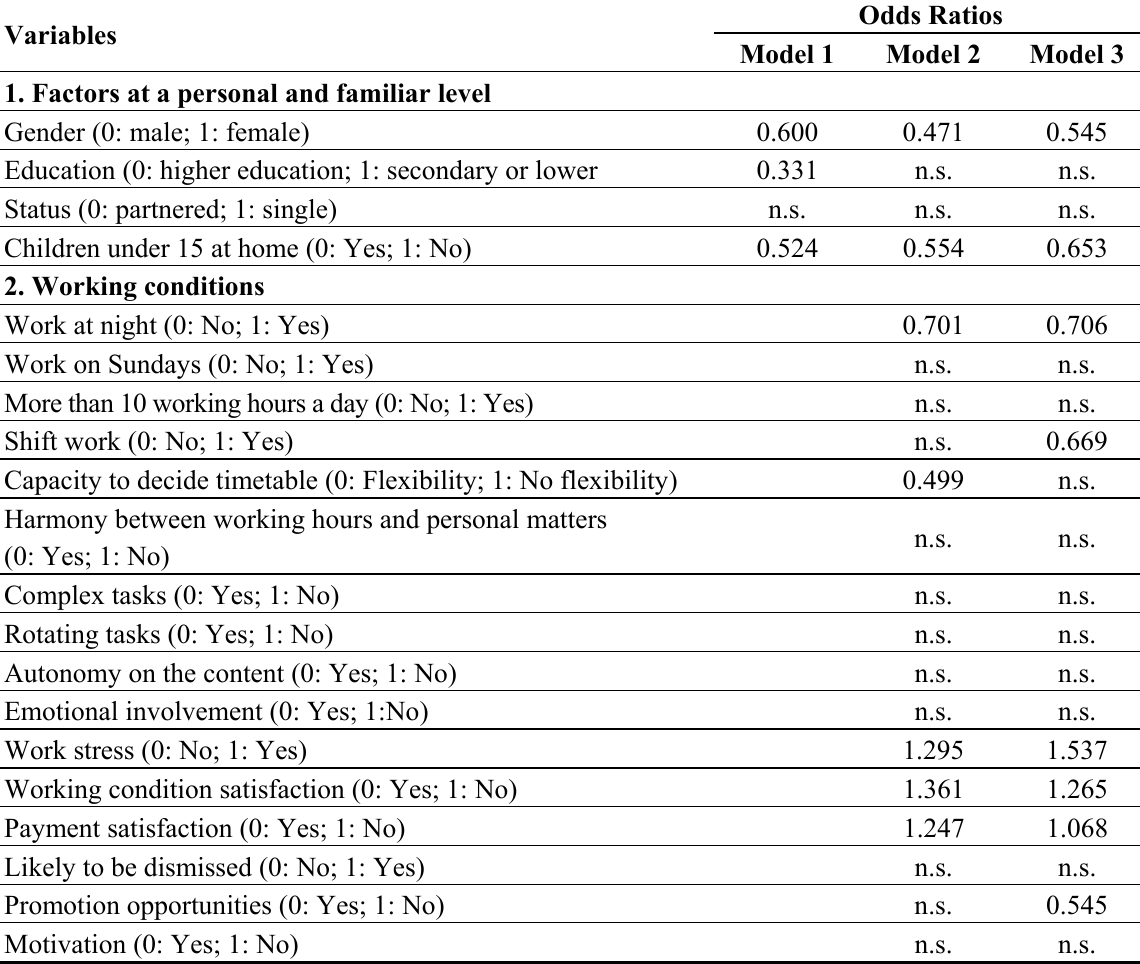
Table 2. Logistic regression: factors that determine workplace